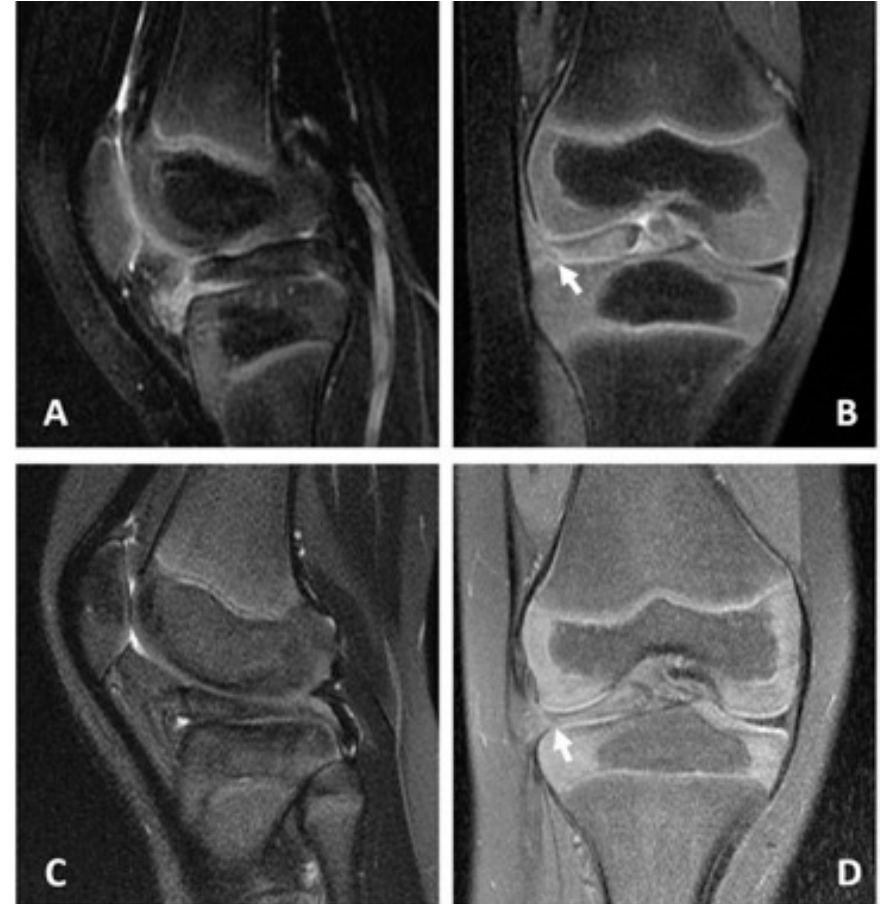
Figure 1. Preoperative MRI of the affected knees for the two cases. ( A ) coronal and ( B ) sagittal planes for the case of the 28-month-old girl. ( C ) coronal and ( D ) sagittal planes for the case of the 5-year-old boy. Both lateral menisci revealed increased thickness and flattening, loss of the natural bow-tie configuration, and a peripheral tear in the posterior horn. The white arrow indicates the peripheral tear site. MRI: magnetic resonance imaging.